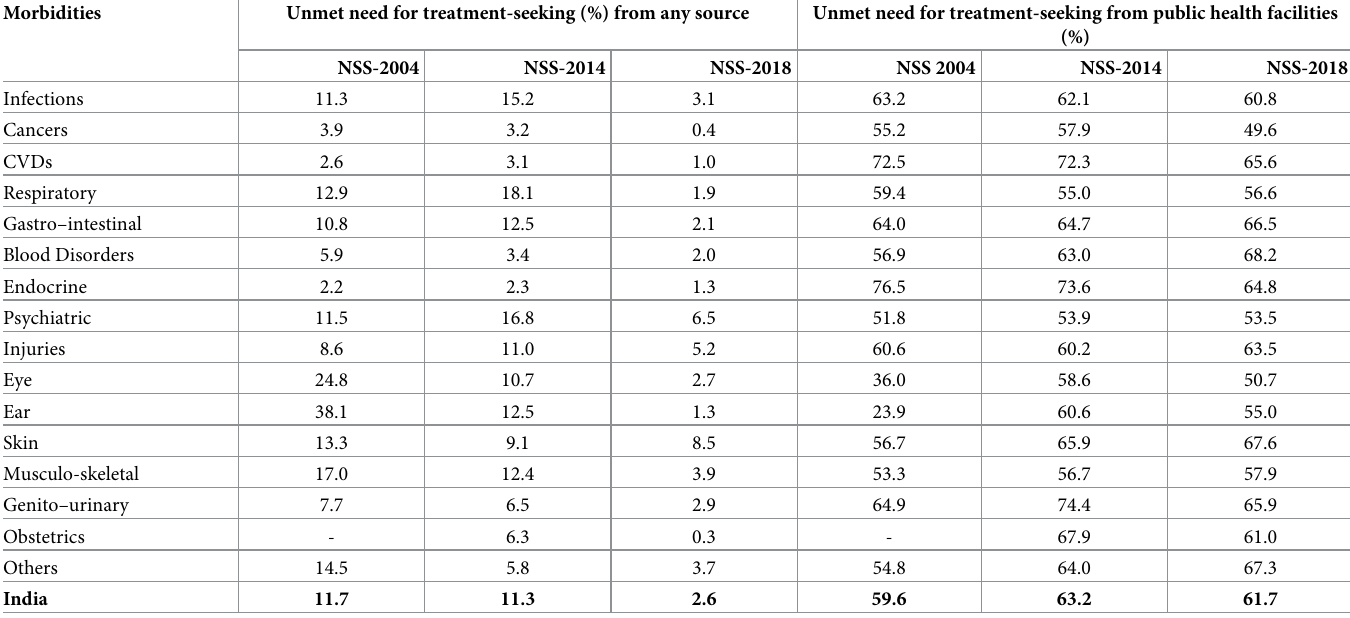
Table 3. Unmet need for treatment-seeking from any source and treatment-seeking from public health facilities among who have suffered/are suffering from selected morbidities in India, NSS, 2004–2018. Morbidities Unmet need for treatment-seeking (%) from any source Unmet need for treatment-seeking from public health facilities